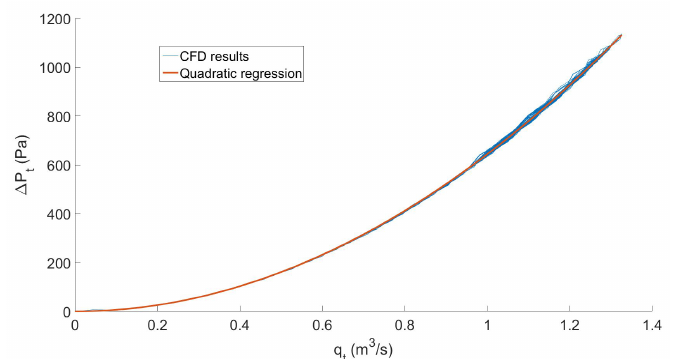
Figure 8. Flow rate across the turbine-orifice as a function of the pressure drop with quadratic regression ( R 2 = 0.9996).